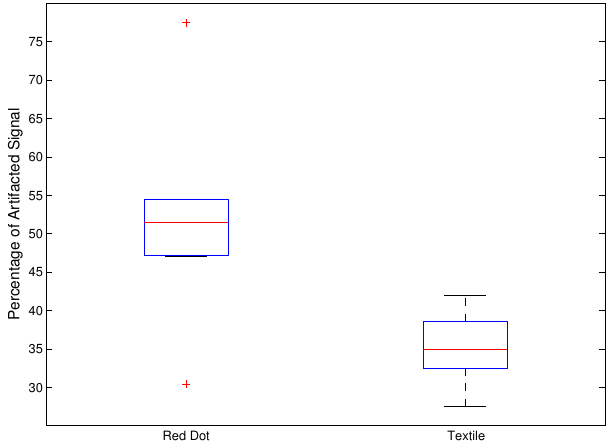
Figure 3. Boxplot of the percentage of artifact signals observed in the two categories of data acquired. The central box represents the central 50% of the data. In fact, its lower and upper boundary lines are respectively at the 25% and 75% quantile of the data. A central red line indicates the median of the data. Finally, two vertical lines indicate the remaining data that are outside the central box and not considered as